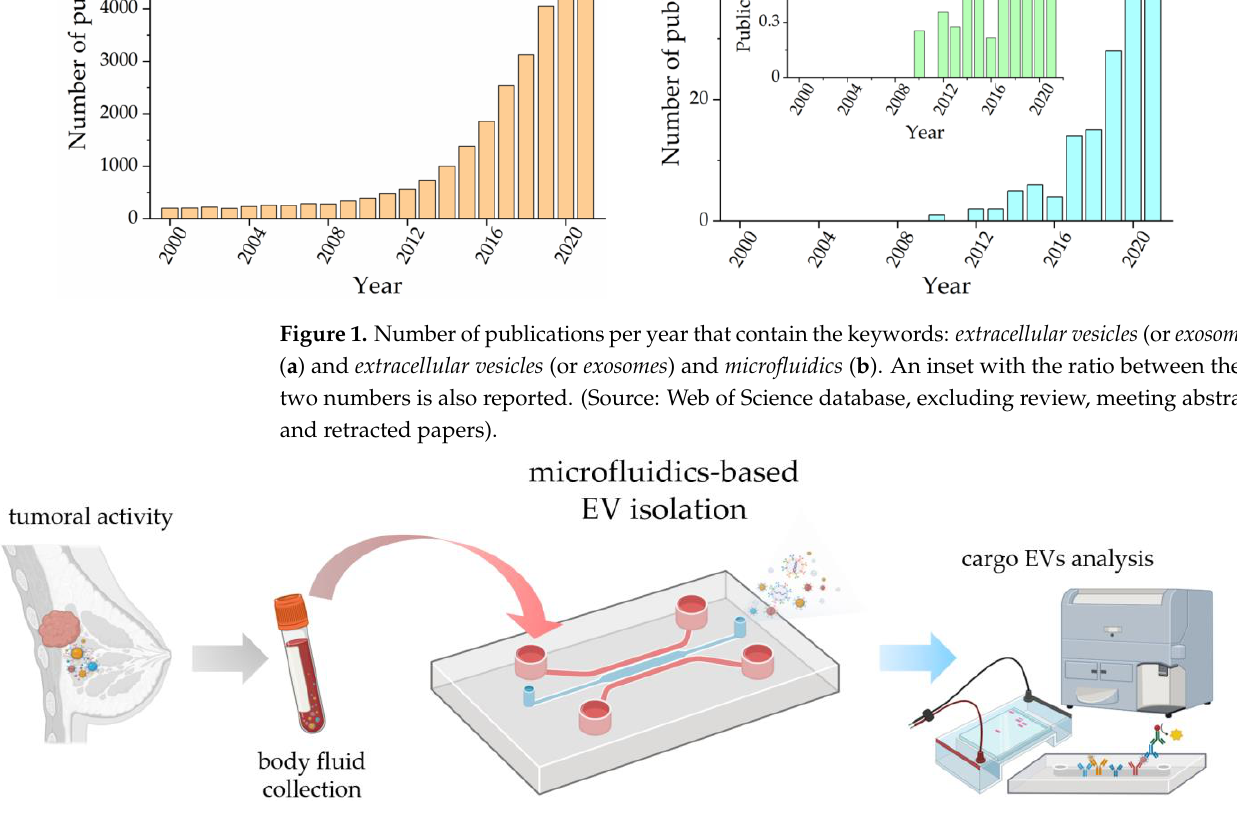
Figure 1. Number of publications per year that contain the keywords: extracellular vesicles (or exo- somes ) ( a ) and extracellular vesicles (or exosomes ) and microfluidics ( b ). An inset with the ratio between these two numbers is also reported. (Source: Web of Science database, excluding review, meeting abstract, and retracted papers).